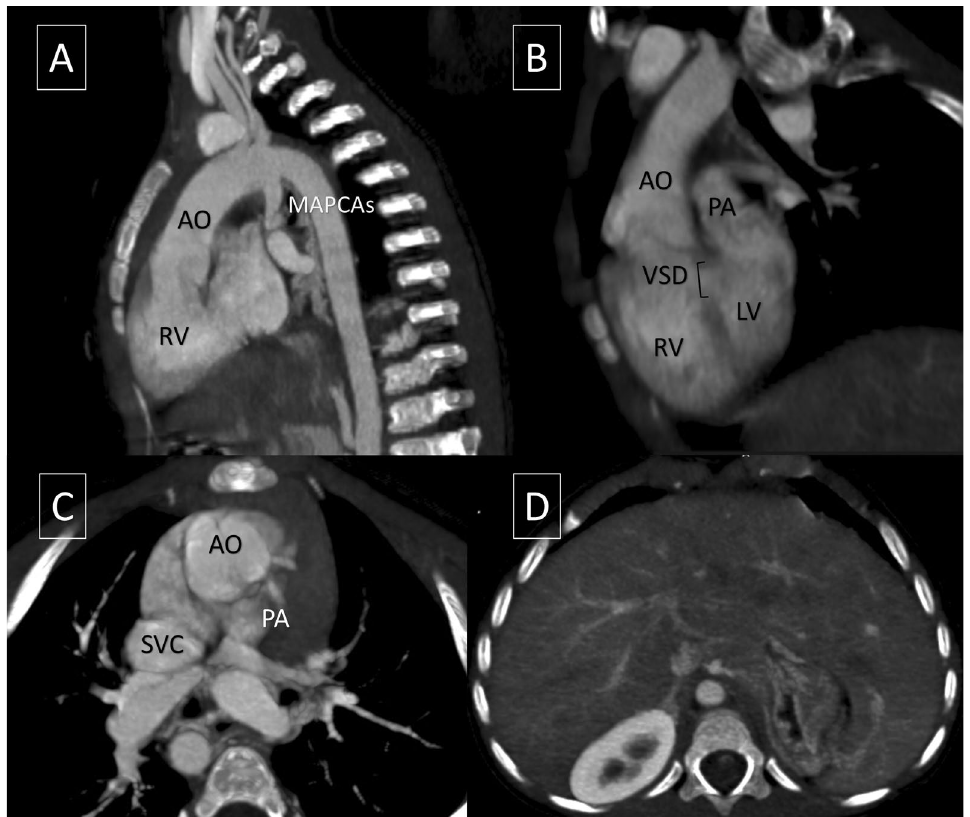
Fig. 2 Sagittal, coronal and axial section of cardiac CT angiography of the cardiac vasculature. Aortic root is originated from the right ventricle (RV). The aorta continues on the right side, with an apparent connection to the right pulmonary aberrant artery at the level of the aortic arch via the major aortopulmonary collateral arteries (MAPCAs) ( A ). Main pulmonary artery originates from left ventricle and appears atretic with only connection to the left pulmonary artery (PA) ( B , C ). Aortic valve is located on the anterior right to the pulmonary valve confirming the spatial relationship of semilunar cusps in D-TGA ( C ). The liver is transversal in position and located in the midline, and no spleen was identified, suggesting a possible heterotaxy syndrome, along with the cardiac anomaly ( D